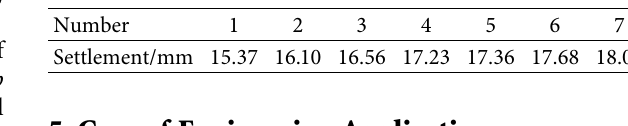
Table 1: Measured data of settlement at point